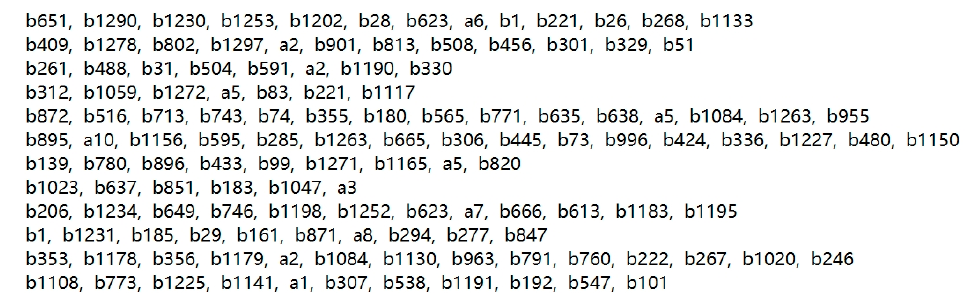
Figure 10. A fragment of the third type of data. Each row denotes a normal session.